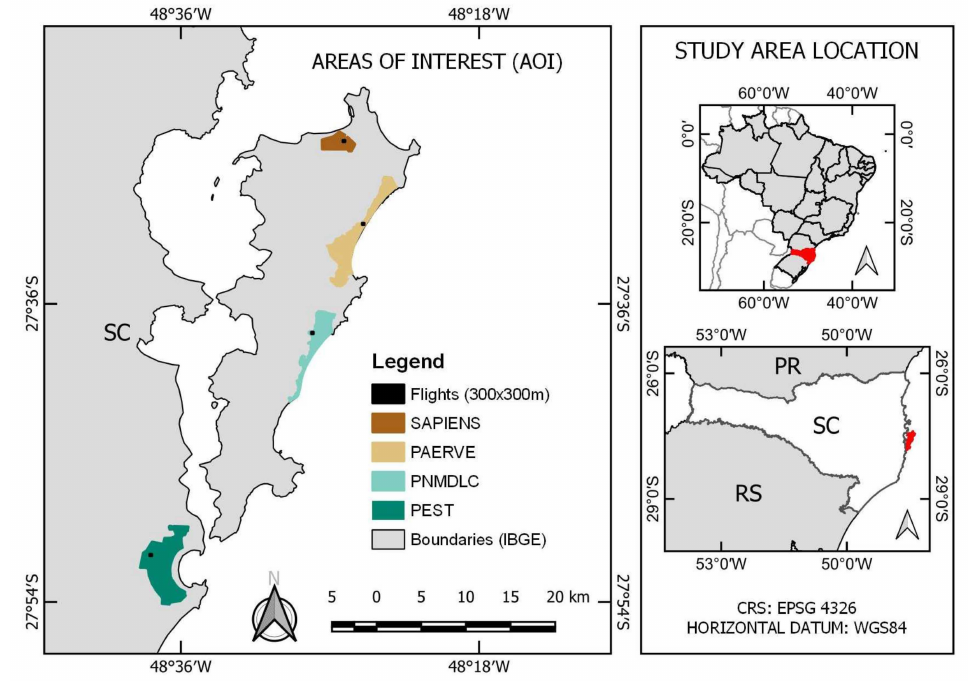
Figure 1. Map revealing areas of interest. Acronyms: Sapiens Park (SAPIENS), Rio Vermelho State Park (PAERVE), Lagoa da Conceiç ã o Dunes Municipal Natural Park (PNMDLC), Serra do Tabuleiro State Park (PEST) and IBGE (Brazilian Institute of Geography and Statistics). Coordinate Reference System (CRS): European Petroleum Survey Group (EPSG) code 4326 (Geographic Coordinates, horizontal datum